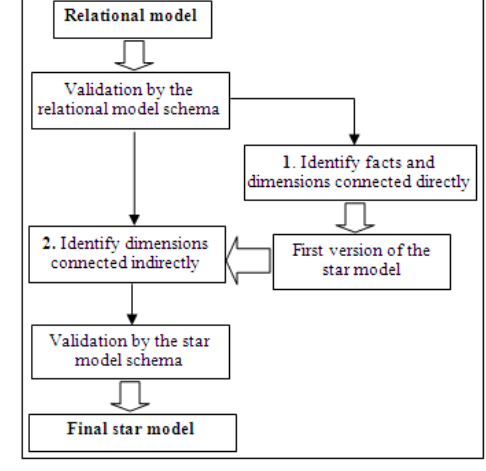
Fig. 2. The multidimensional meta-model for the star schema